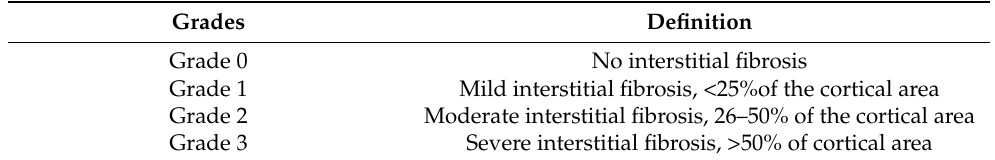
Table 2. Banff classification of IF/TA